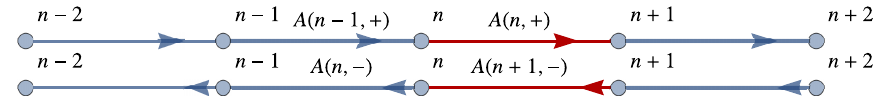
Figure 20. Gauge field A ( n, +) ≡ A ( n ) ≡ A 1 ( n ) living between sites is specified by its starting site and its spatial